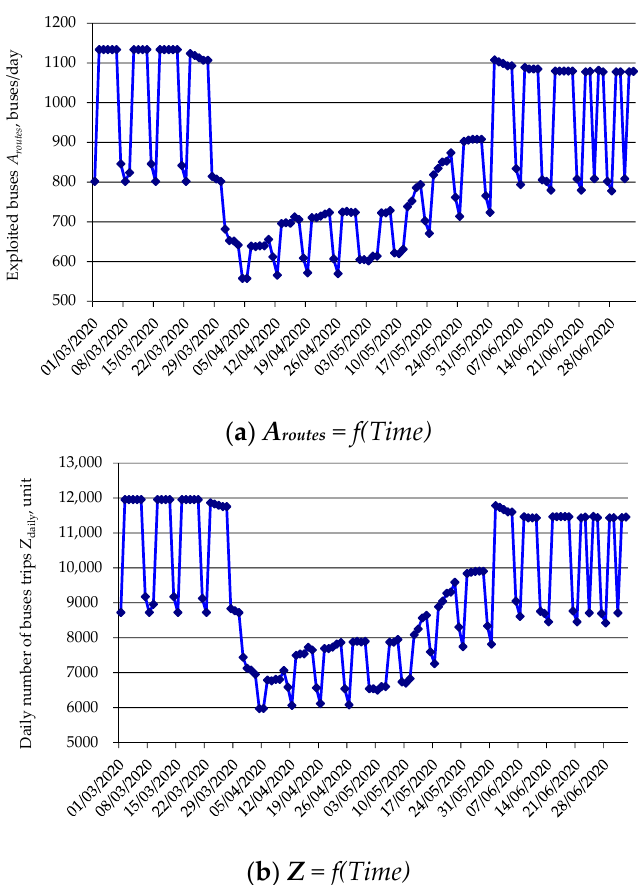
Figure 5. Change in the number of buses in operation А routes , and the number of executed trips Z on Tyumen CPPT routes in the period 1 March to 5 July, 2020.